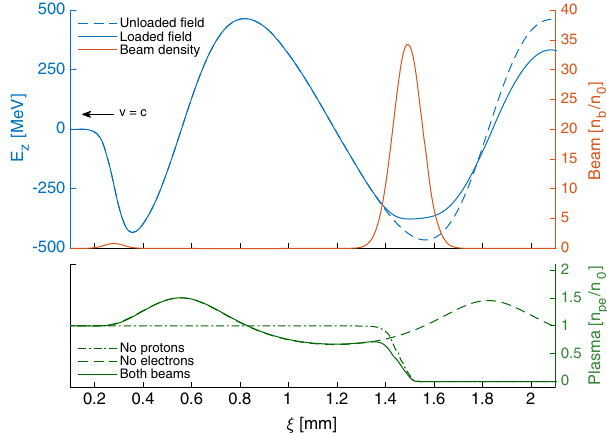
FIG. 3. Top plot: Unloaded longitudinal electric field with no witness beam (dashed blue line) and loaded field (whole blue line) along the beam axis. The beam density along the axis for both beams are shown in red. Bottom plot: Plasma densities along the beam axis for a drive beam with no witness beam (dashed green line), witness beam with no drive beam (dash-dotted green line), and both beams present (continuous green line). The position in the simulation box ξ ¼ z − tc , moving toward the left. The plots show the initial time